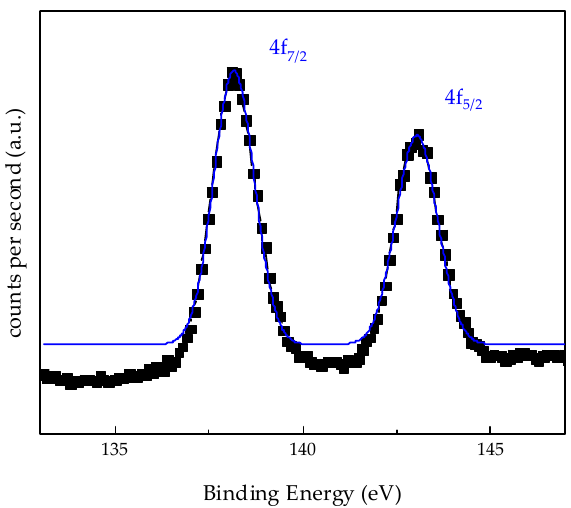
Figure 10. X-ray Photoelectron Spectroscopy spectra of Pb4f core levels after lead ion adsorption on 0.3NH 2 / DMS-1 adsorbent from solution with Pb(II) initial concentration 100 ppm